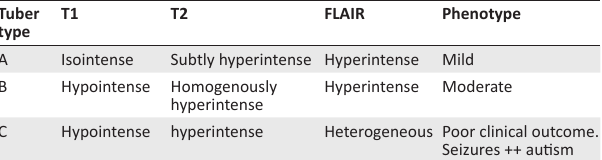
TABLE 3: Tuber subtypes based on MRI features in tuberous sclerosis and associated phenotypic